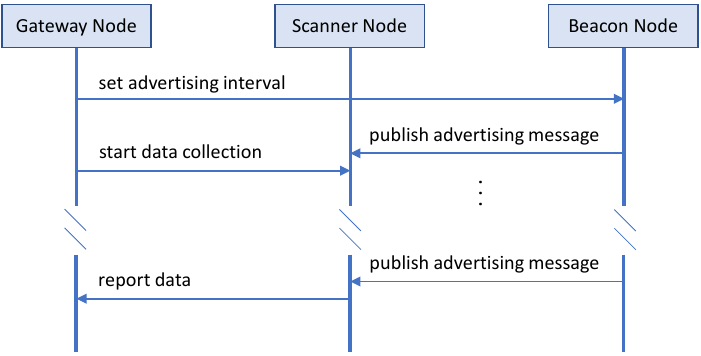
Figure 4. Communication protocol in the mesh network for data collection.